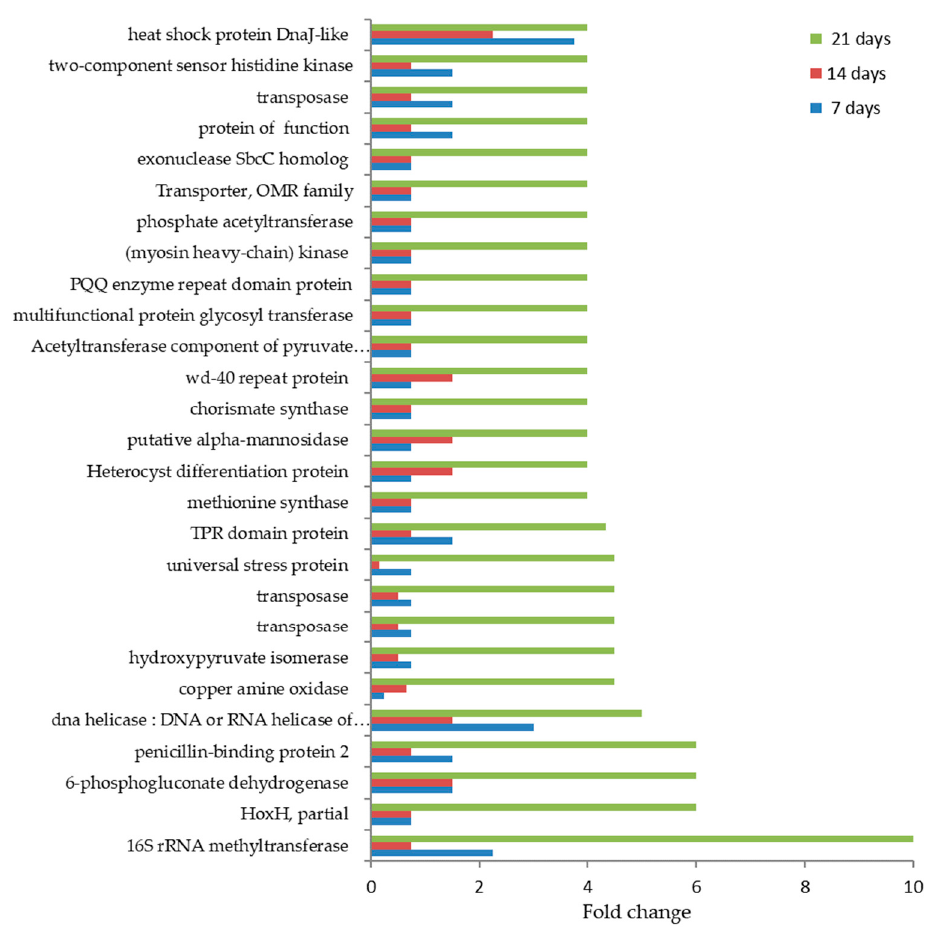
Figure 12. Time course of the highly differentially accumulated proteins during the treatment in treated A. maxima cultivation with 0.2 mM glyphosate compared to the reference cultivations. Values are reported as fold changes (Supplementary Table S2).